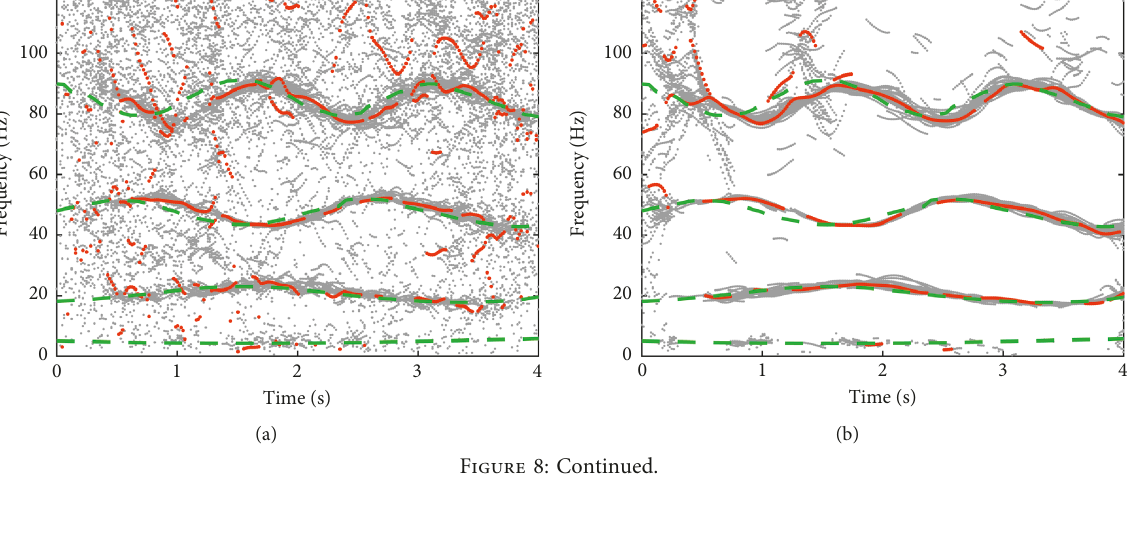
Figure 7: Natural frequency and power spectral density estimates by LS (a, c) and RR (b, d) for the laboratory TV structure when N (gray dots: natural frequency estimates from the 30 Monte Carlo tests; red dots: natural frequency estimates from the single test; green dashed lines: baseline values of natural